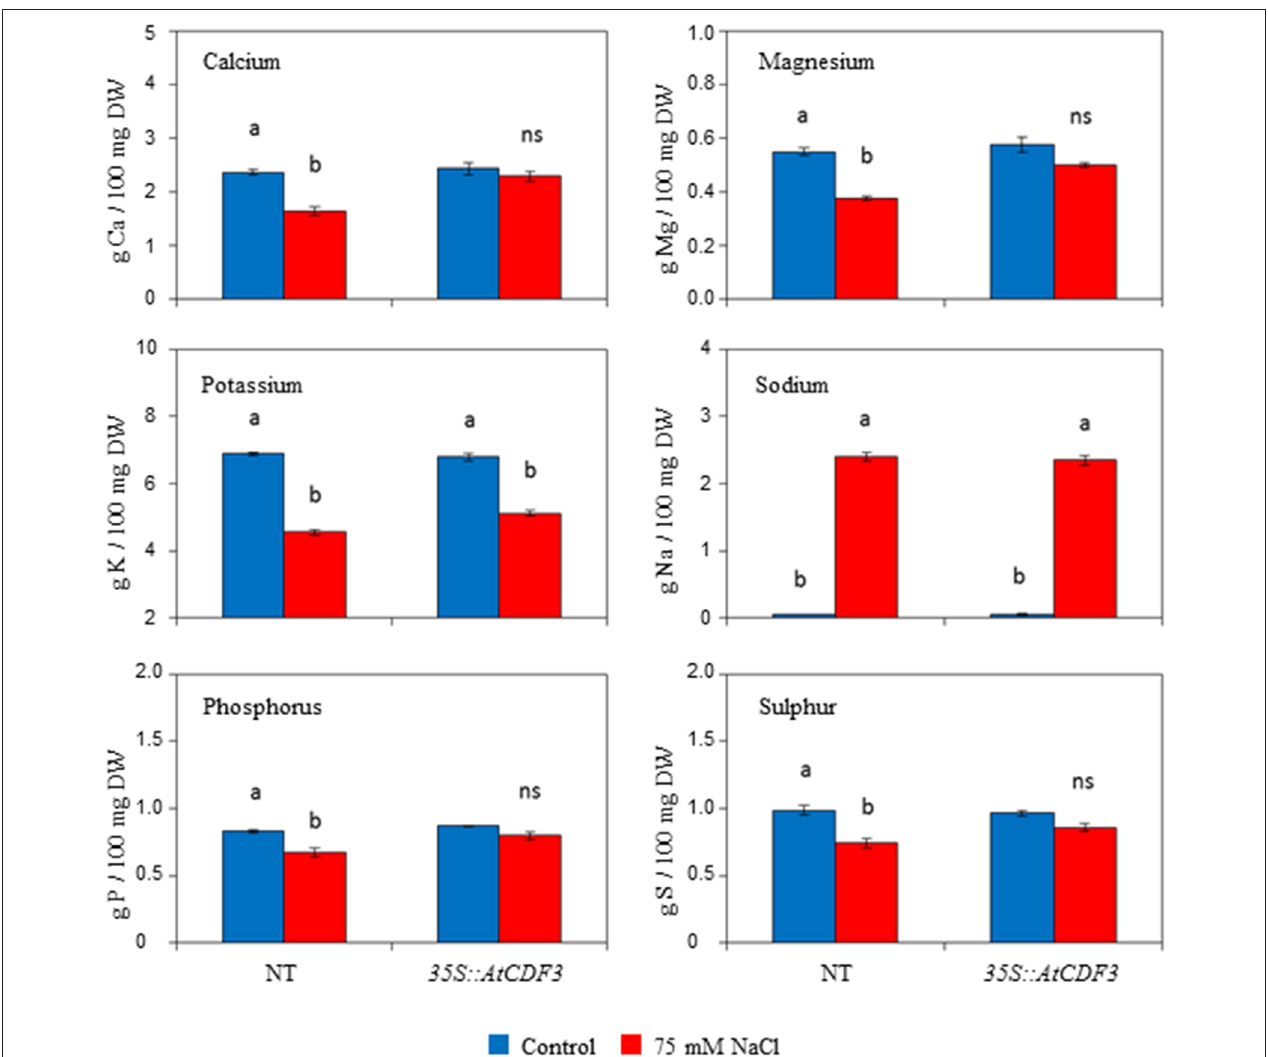
FIGURE 7 | Effect of AtCDF3 overexpression on leaf mineral elements content in tomato. Thirty-day-old plants grown in hydroponic culture were subjected to moderate salinity (75 mM NaCl). Mineral elements determinations were performed after 15 days of treatment. The calcium, magnesium, sodium, potassium, phosphor, and sulfur levels were shown under the control (blue bars) and salinity (red bars) conditions in the NT and 35S::AtCDF3 plants (line 2.3). Different letters indicate the significant differences ( P < 0.05) within each genotype for the stress effect. NT,